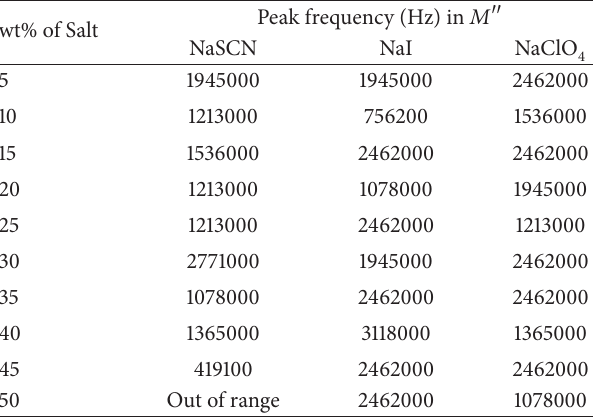
Table 4: Values of relaxation peak frequency in imaginary part of , (b) NaI, and (c) NaSCN Modulus versus frequency 4